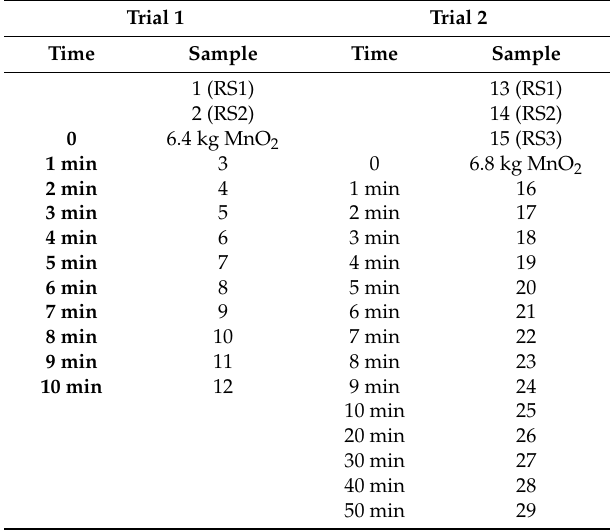
Table 2. Timetable for the sampling and tracer addition for Trials 1 and 2. RS: Reference Sample, which refers to the samples taken before the tracer powder was